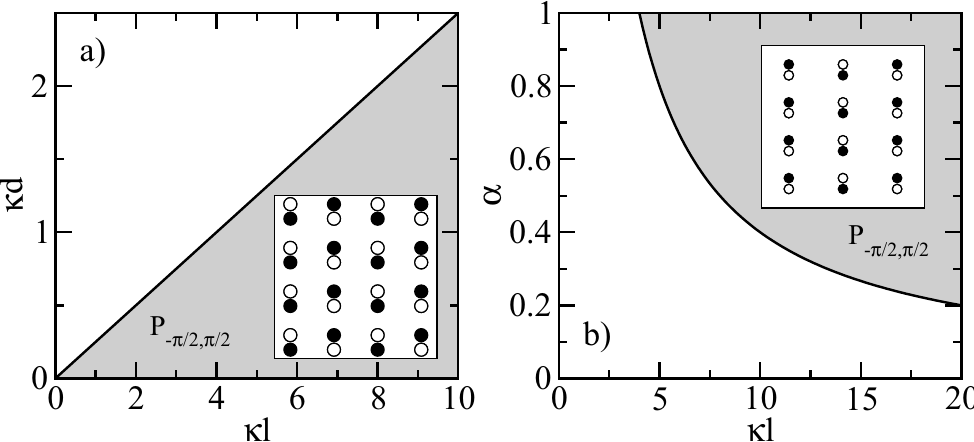
Fig. 6 – Ground state phase diagram of oppositely charged dimers on a rectangular lattice for (a) α = 1 π/ 2 ,π/ 2 phase sketched in the insets is the ground state for all values of α , κ l and κ d . and (b) κ d = 1. The P −